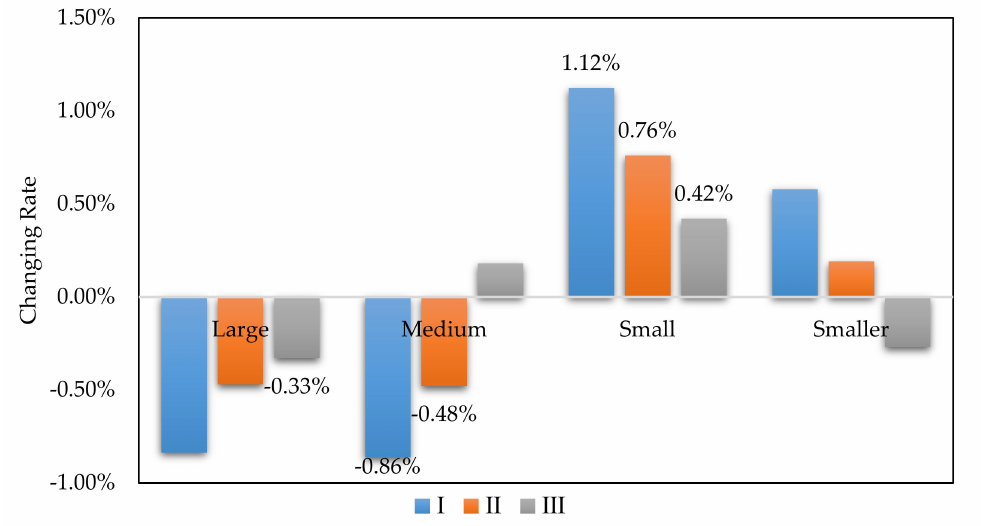
Figure 13. The glacier change statistics at different